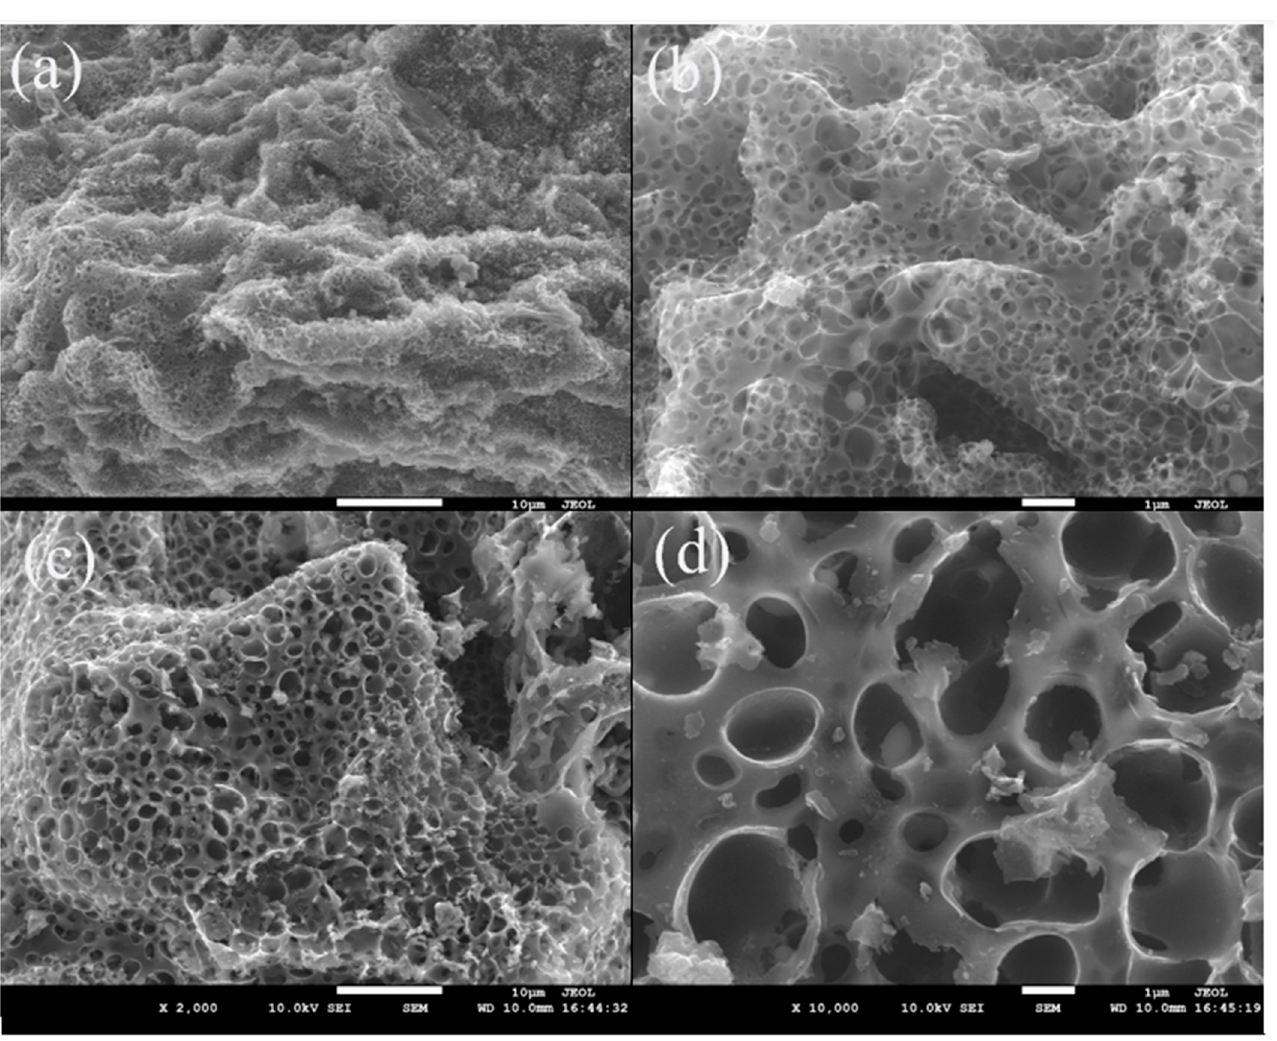
Figure 1. SEM images of L-600 ( a , b ) and L-CN-600 ( c , d ) samples.